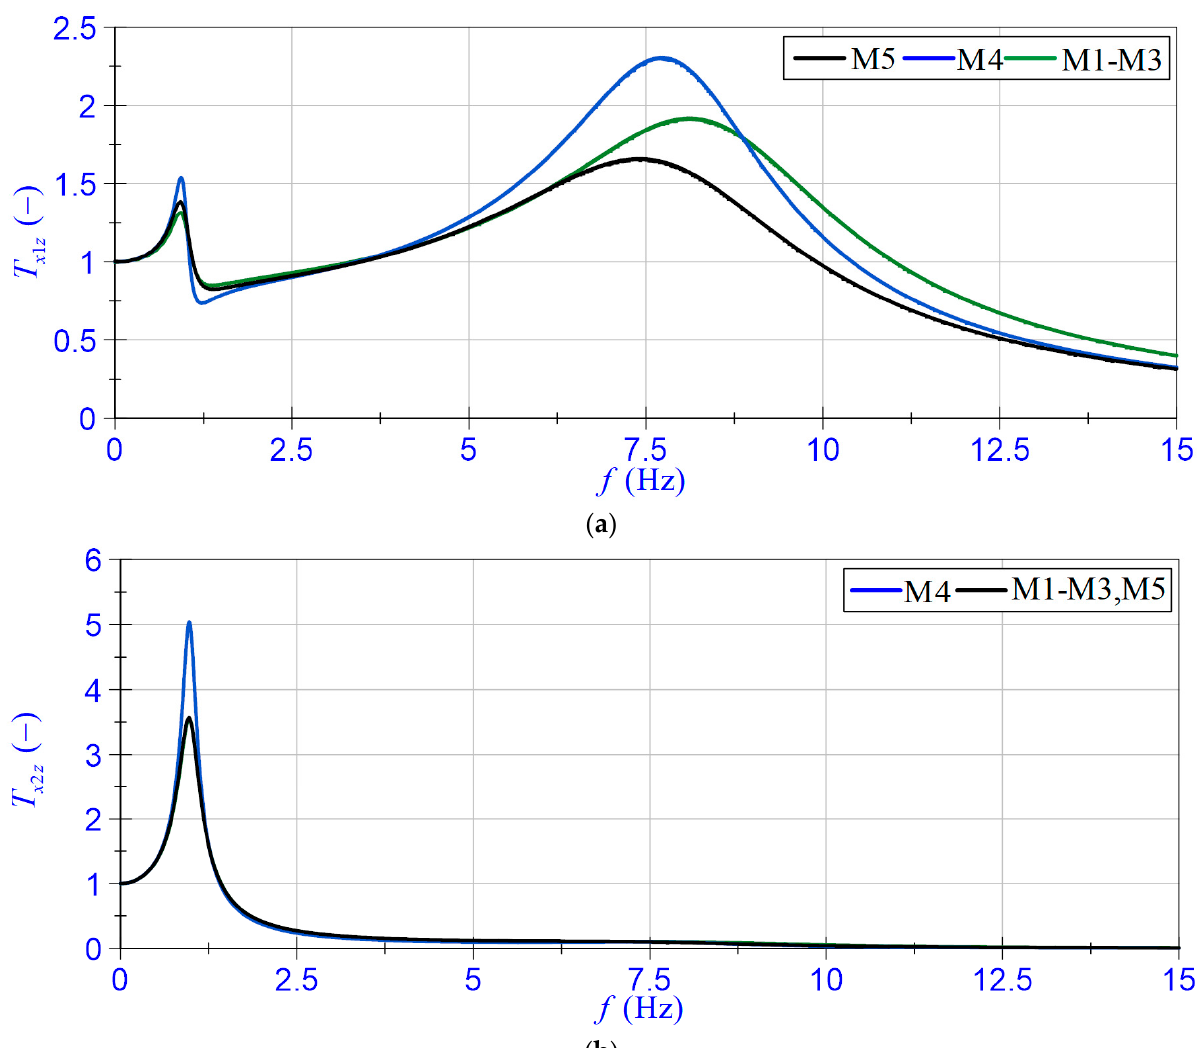
Figure 4. Time patterns: ( a ) displacement (cid:1878) and (cid:1876) (cid:2869) ; ( b ) displacement (cid:1878) and (cid:1876) (cid:2870) –PVRS .